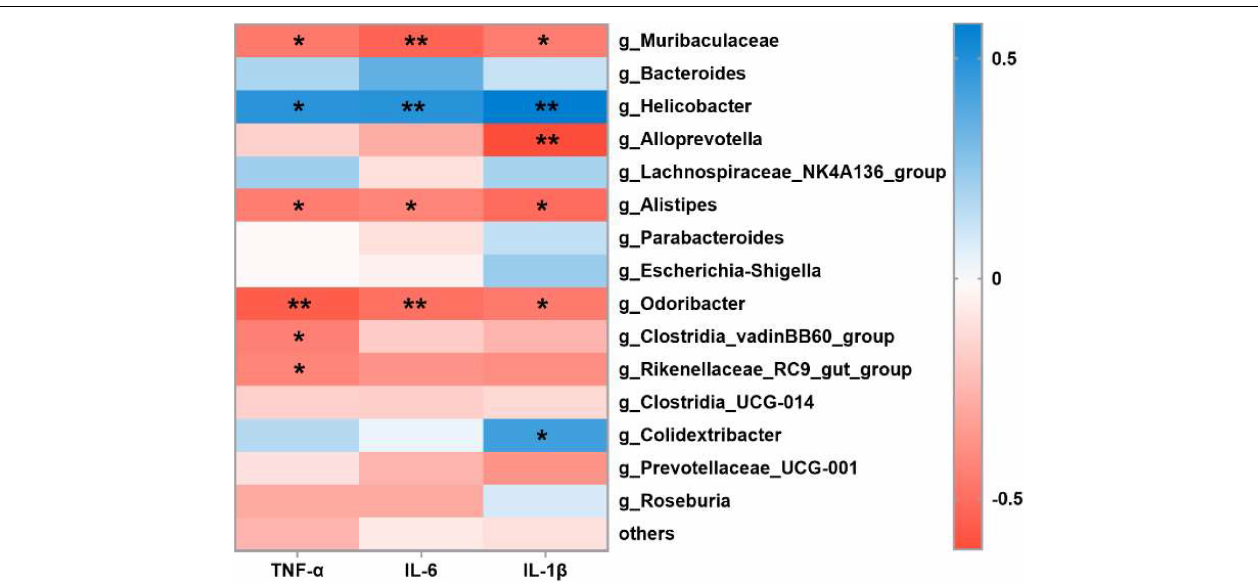
FIGURE 6 | Interrelationship between gut microbiota and pro-inflammatory cytokines. Heatmap of Spearman’s correlation between gut bacteria (at the genus level) and pro-inflammatory cytokines. Significant difference determined at * p < 0.05, ** p <